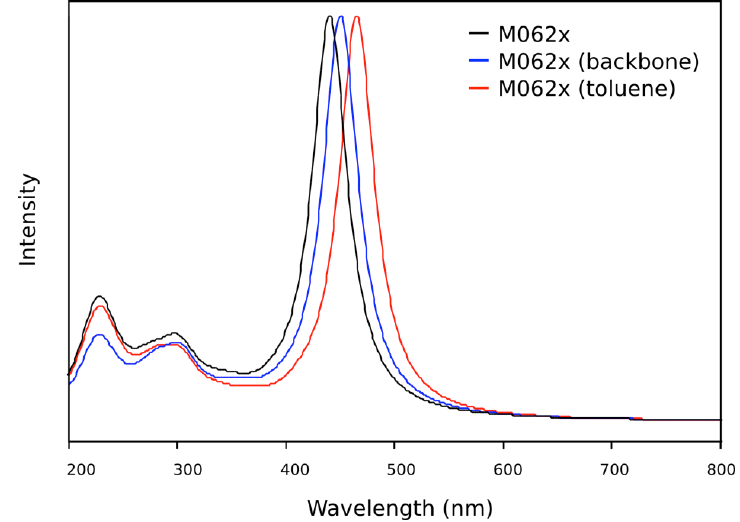
Figure 8. Theoretical UV/visible spectra of the OIC1MS molecule calculated with the M062x functional. The calculation was performed with the whole molecule without solvent (black line), with the aromatic backbone without solvent (blue line) and with the aromatic backbone and the implicit solvent parameters for toluene (red line).